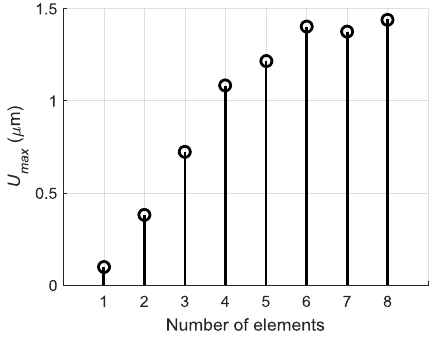
Figure 17. Dependency of maximum displacements amplitude U max versus number of excited array elements.